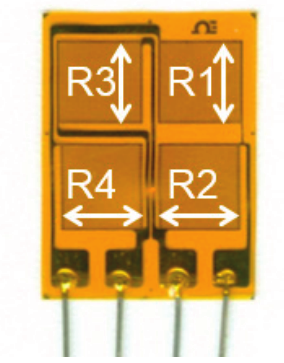
Figure 4. Photograph of the steel test specimen. The area within the dotted line represents the location of the sensing sheet. Dimensions in inch (1 inch = 25.4 mm).